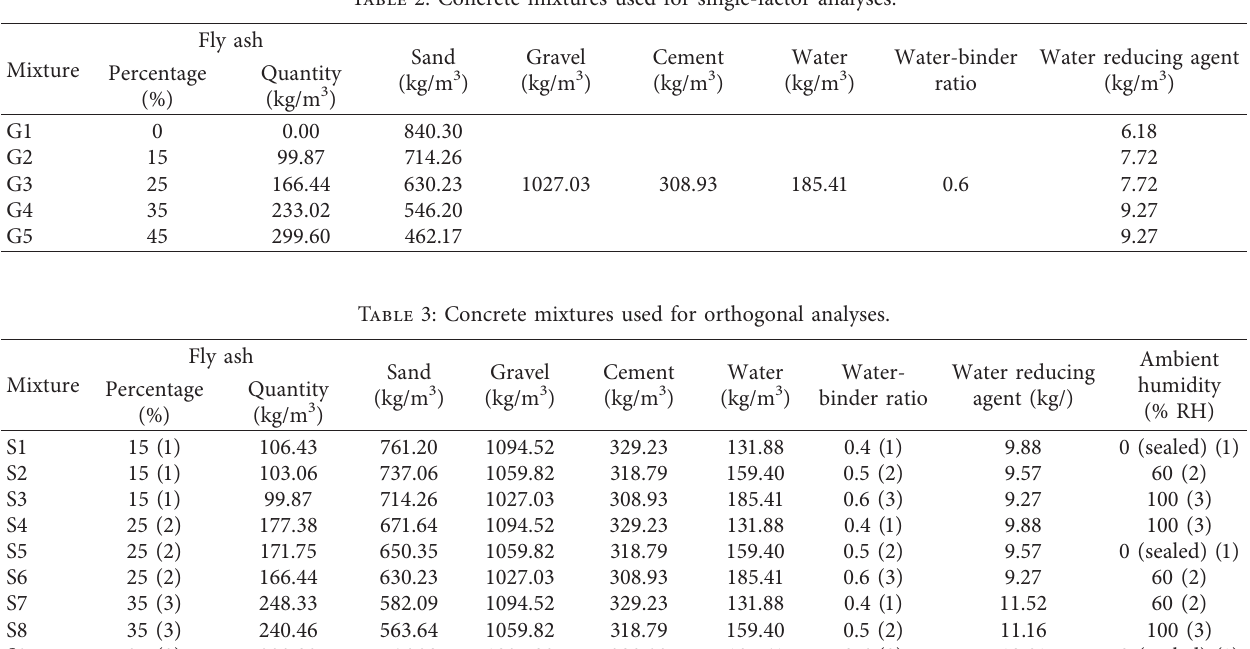
Table 2: Concrete mixtures used for single-factor analyses.